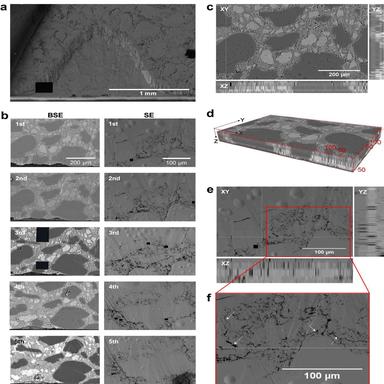
BIB-SST imaging results of M 0.50 mortar. a, Milled area revealing the pseudo-Gaussian beam profile. b, Successive milled sections acquired in BSE and SE modes. c–d, Orthogonal views (c) and 3D renderings (d) of the reconstructed image volume in BSE mode. Dimensions in μm. e–f, Orthogonal views in SE mode (e) showing microcracks in a close-up (f).